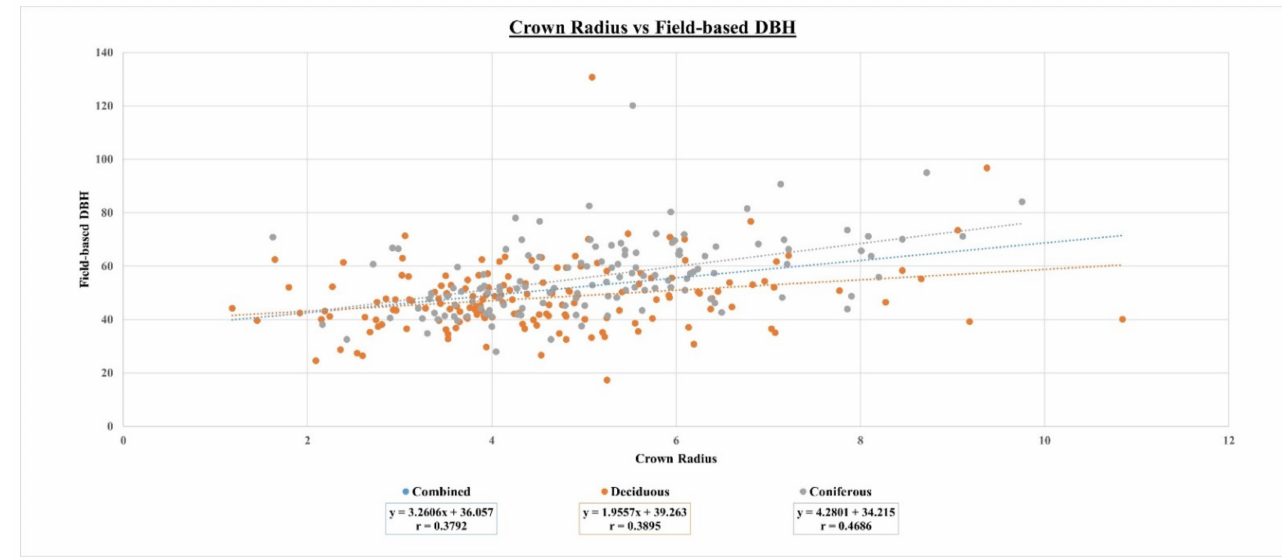
Figure 3. Linear regression between field measured dbh and crown radius estimated using UAS tree segments. A total of three trend lines and their respective equations are displayed for all species combined as well as for the deciduous species and coniferous species